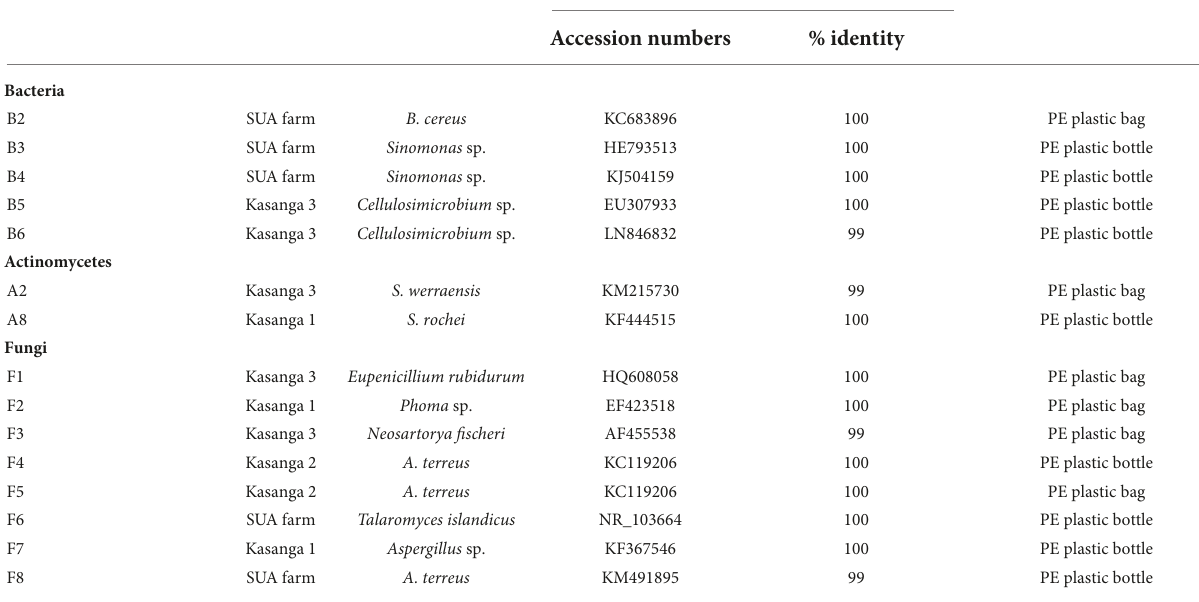
TABLE 6 Identity of plastic-degrading bacteria, actinomycetes, and fungi.